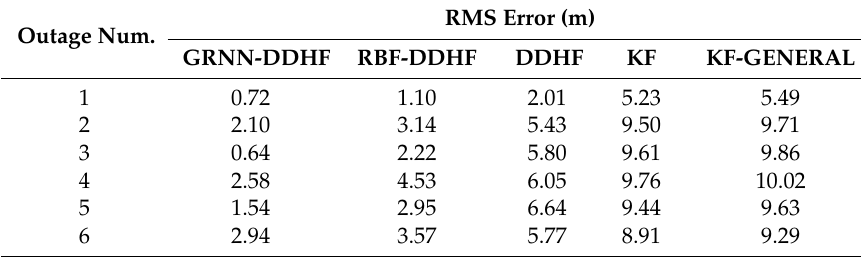
Table 5. RMS position errors during GPS outages for Trajectory 1 with extra simulated uncertain nonlinear drift.